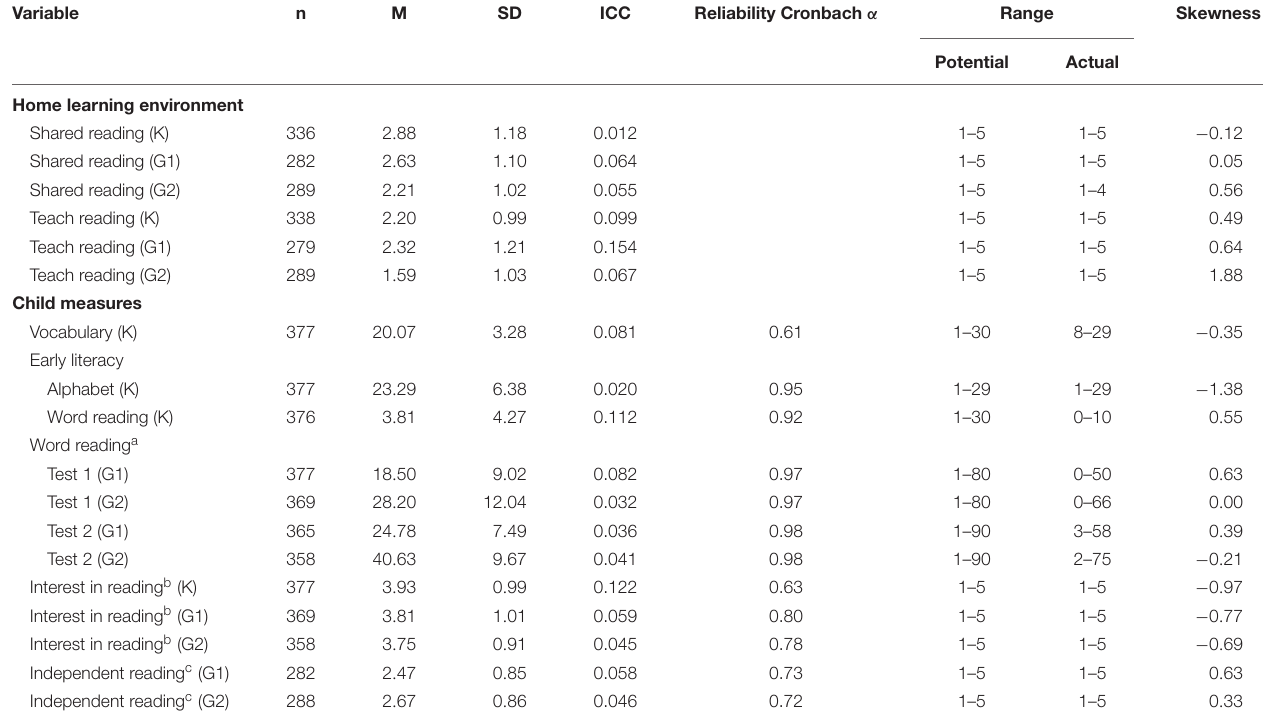
TABLE 1 | Descriptive statistics and psychometric properties at the ends of kindergarten (K), Grade 1 (G1), and Grade 2 (G2). Variable